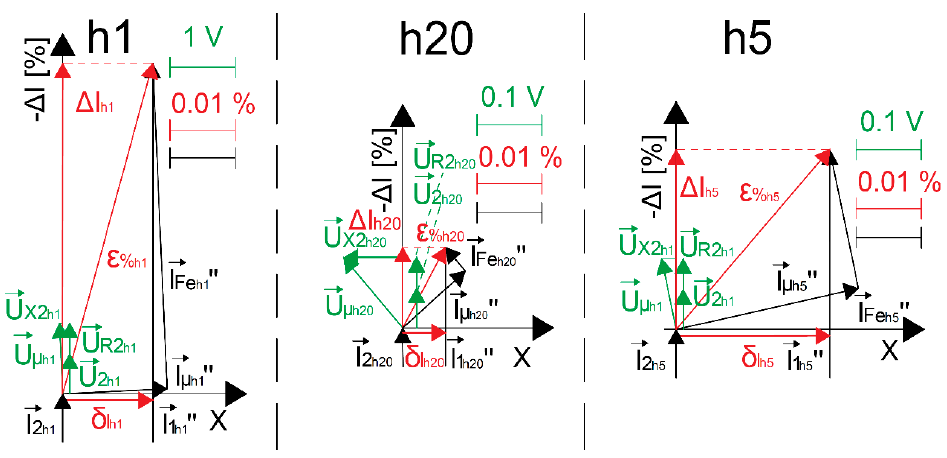
Figure 5. Vectorial diagrams for transformation of the 1st (h1), 5th (h5), and 20th (h20) harmonics of distorted primary current by designed CT (X = sin δ hk · 100%).